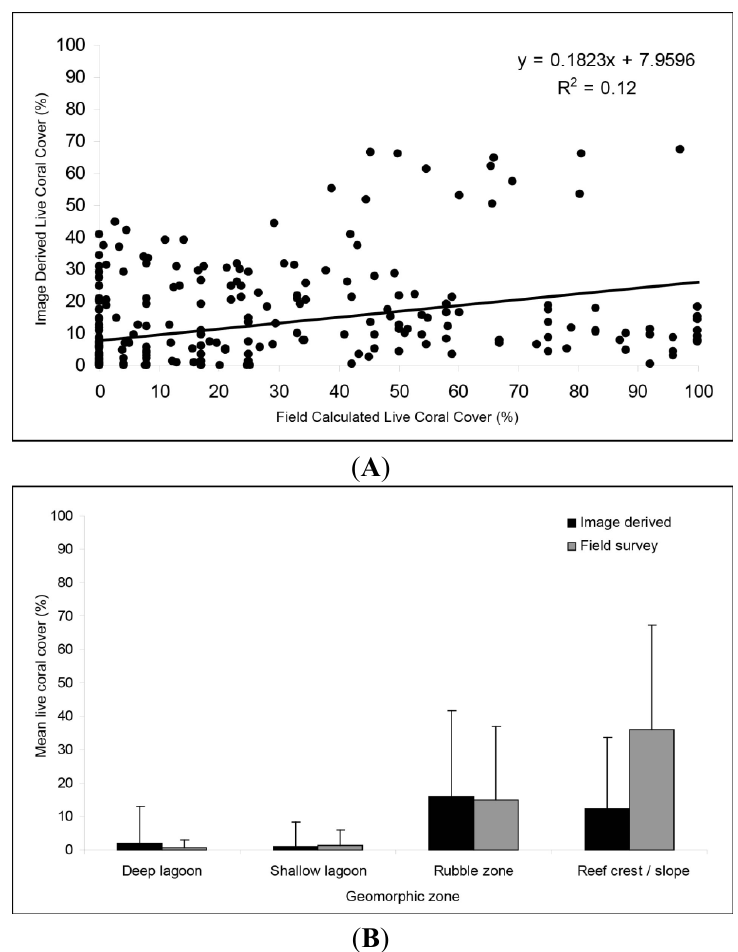
Figure 11. ( A ) Comparison of field survey data with image derived live coral cover estimate for all validation sites; and ( B ) Comparison of mean percentage live coral cover calculated from field and image data per geomorphic zone. Bars indicate standard